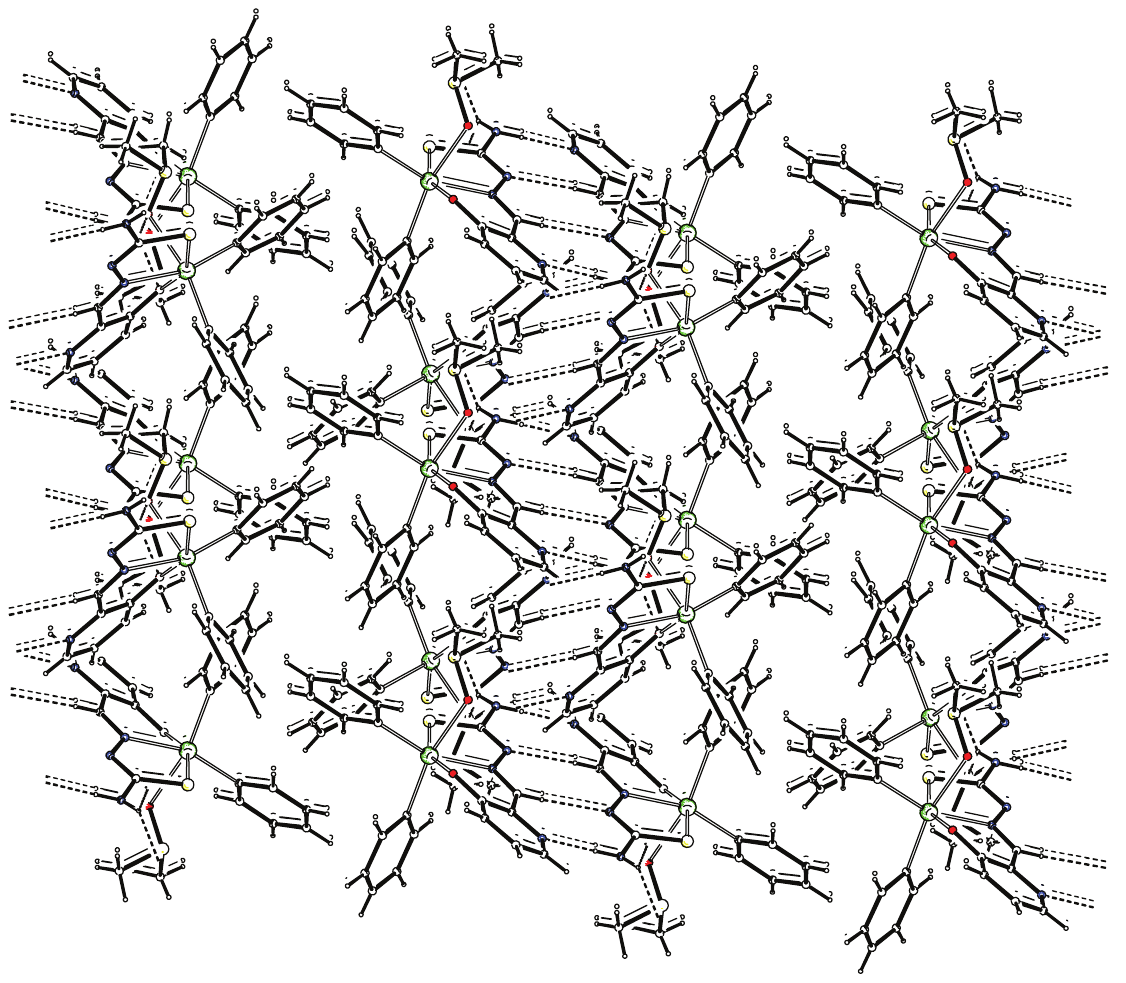
Figure 3: A view of the extended network of 5 along the b axis.